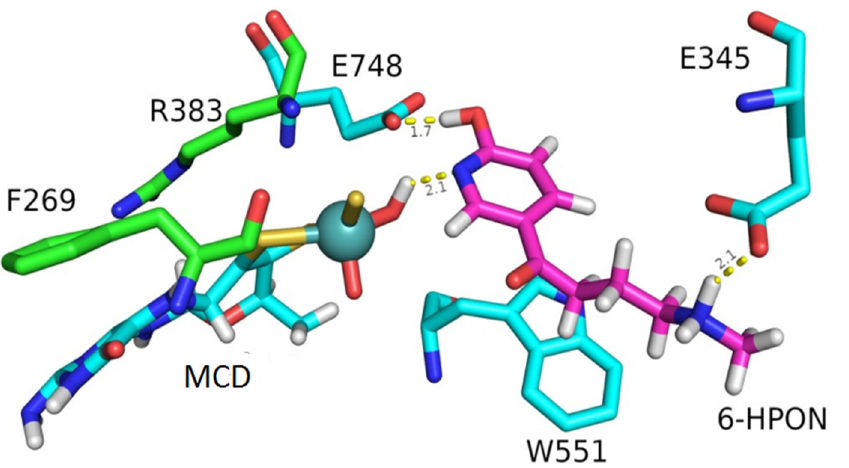
Figure 5. A structural model of the substrate 6-HPON bound at the active site of Kdh. E748, W551, and E345 of KdhL are directly involved in substrate binding. F269 and R383 of KdhL stabilize the conformation of MCD.